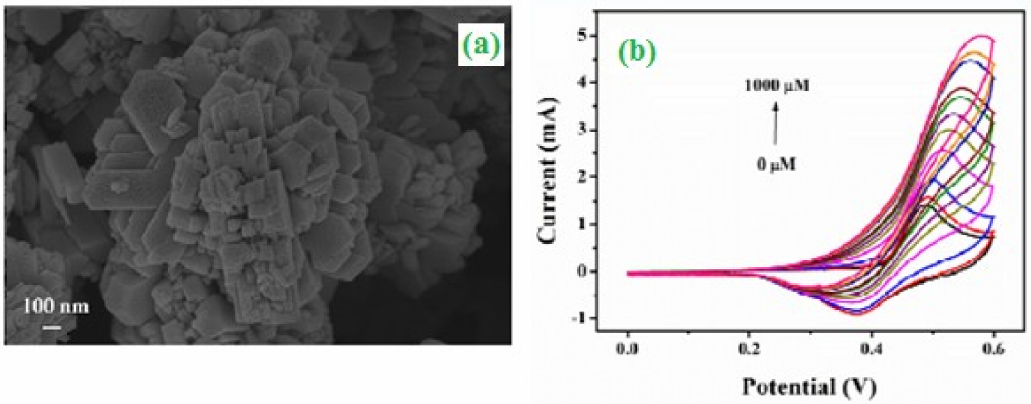
Figure 10. ( a ) High magnification FESEM micrographs of WO 3 -Pd AA ( b ) Cyclic voltammagramme of WO 3 -Pd AA in presence of di ff erent concentrations of glucose. Reprinted with permission from [134]. Copyright (2018), American Chemical